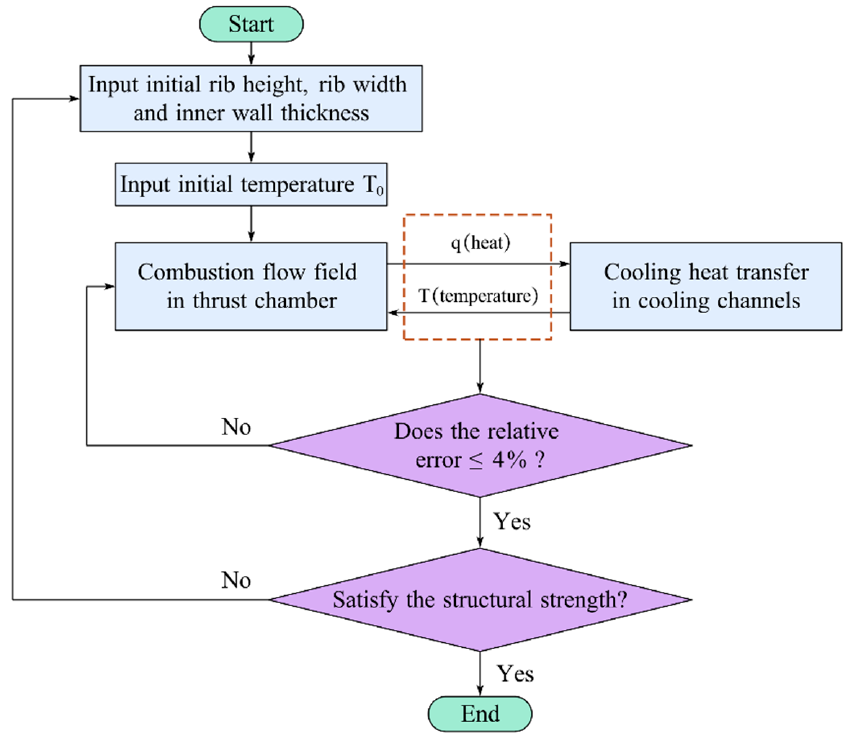
Figure 5. The three-dimensional combustion and cooling coupled calculation process. Step 1: Given the initial temperature distribution on the gas-side wall of the thrust chamber, the turbulent combustion, flow, and heat transfer inside the thrust chamber were simulated numerically, and the heat flow distribution on the gas-side wall was obtained after convergence. It refers to the combustion flow field in the thrust